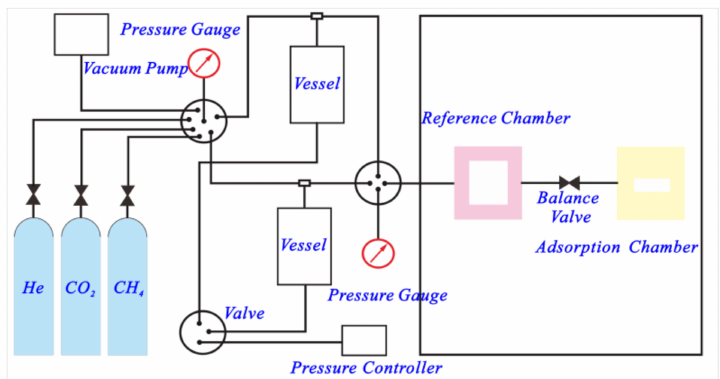
Figure 2. The outline map of the Terratek-300 isotherm adsorption